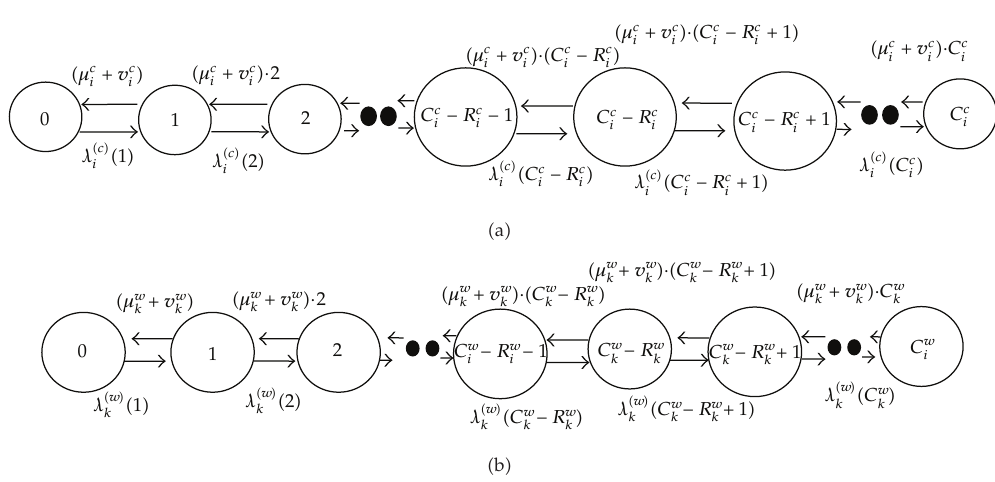
Figure 2: State transition diagrams for each cellular cell (cid:3) a (cid:4) and WLAN (cid:3) b (cid:4)